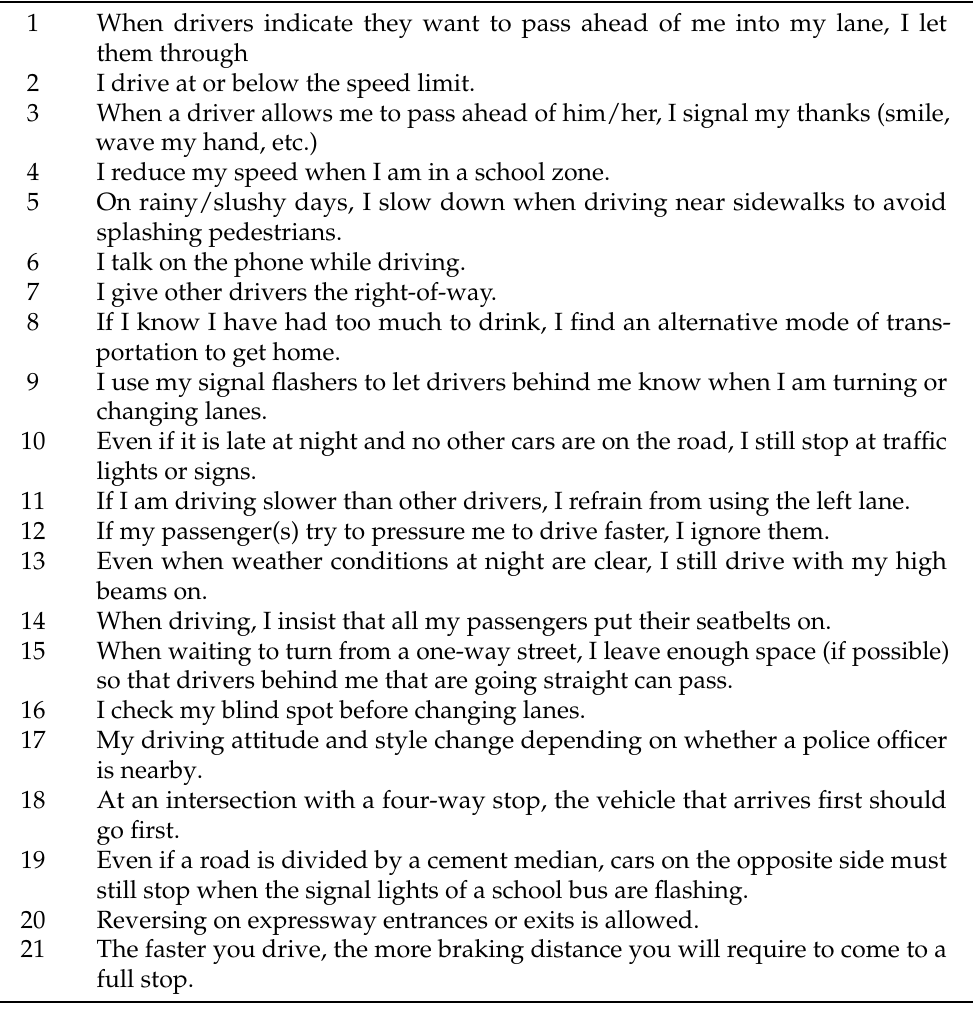
Figure 2. Project flowchart. Table 1. Driving personality